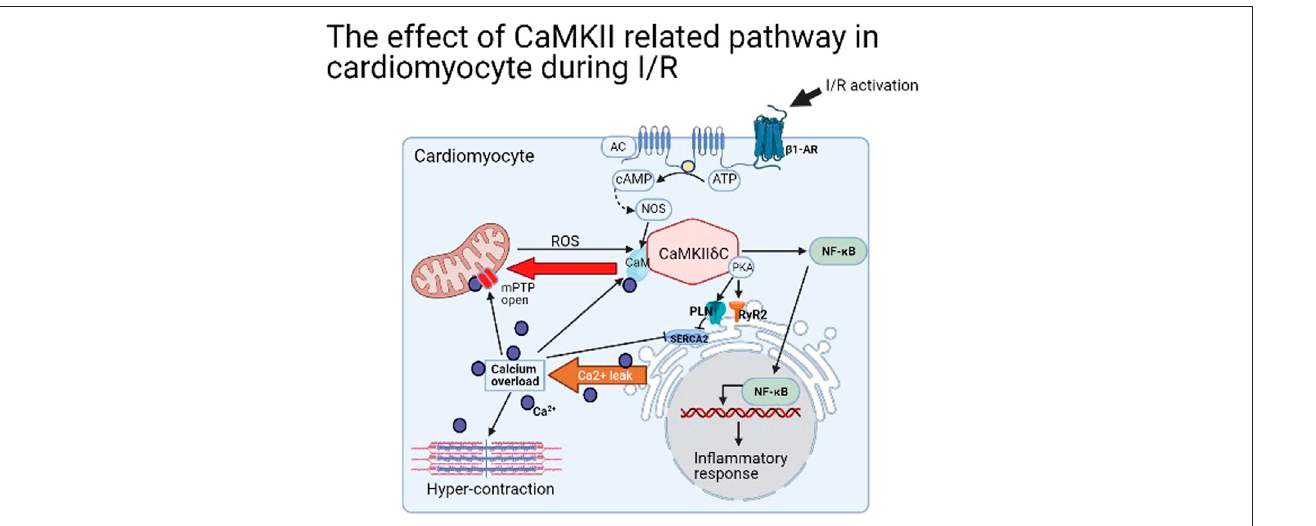
FIGURE 3 | Schema of human CaMKII δ protein